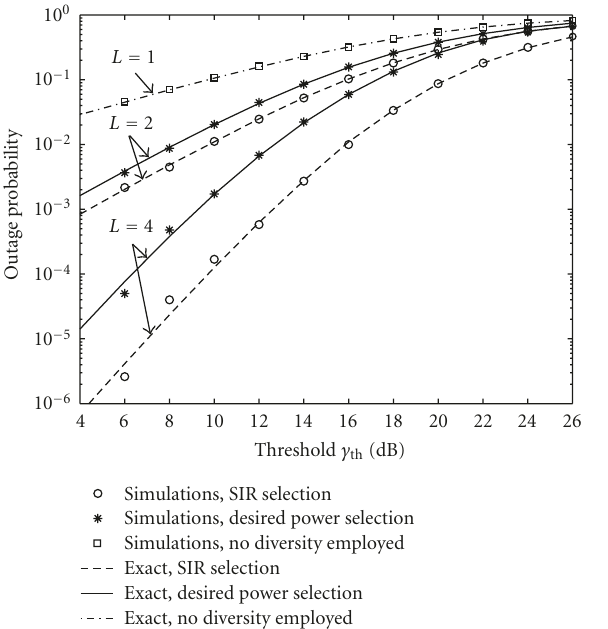
Figure 3: The e ff ect of changing the number of interferers on the performance of the SC receiver employing the maximum desired signal power criterion with m s = m I = 2, β = 1, and SIR av =